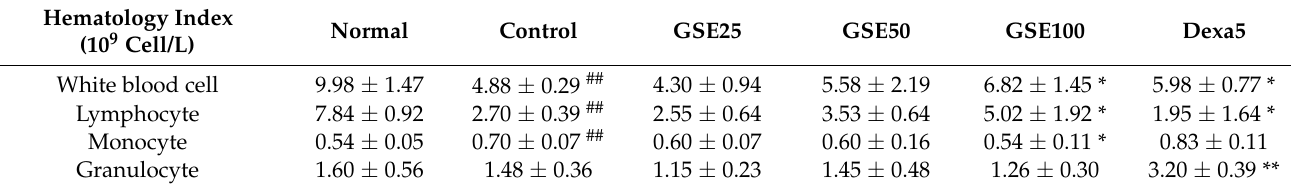
Table 1. Cell blood counting analysis.